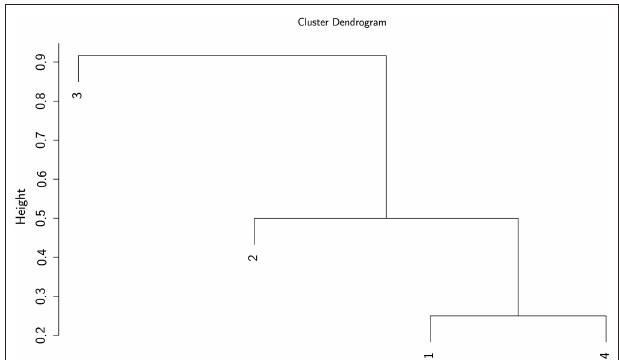
yet effective hierarchical clustering method. We selected the UPGMA algorithm since with UPGMA each genetic distance in the dissimilarity matrix contributes equally to the final